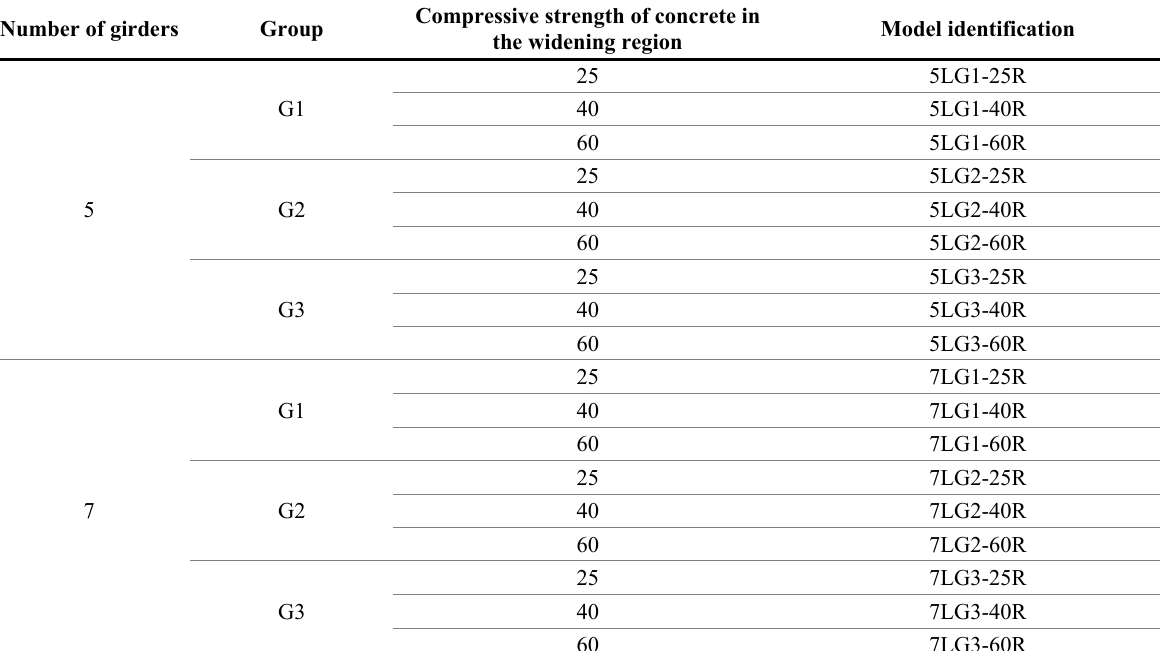
Table 1. Summary of developed models Number of girders Group